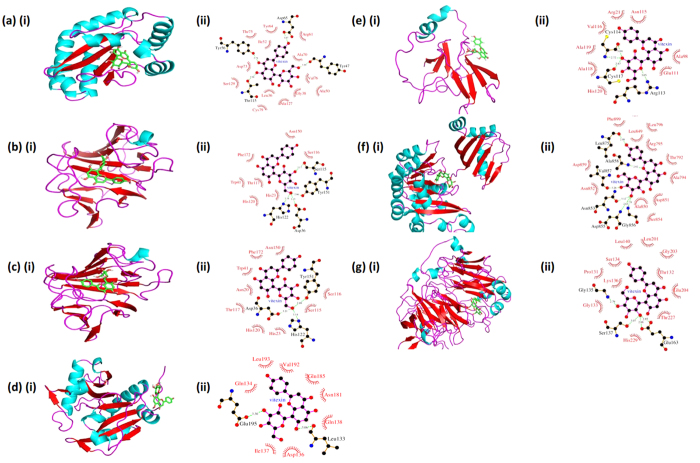
Vitexin docked in different binding pockets of QS and proteins of P. aeruginosa:Cartoon representation of protein-ligand complexes with helices coloured in cyan, beta strand in red and coils in magenta colour. Ligand was coloured green and represented in sticks model. Ligplots of protein-ligand complexes are showing interaction of vitexin with protein residues. (A) (i) Cartoon structure of LuxR with vitexin, (ii) ligplot of LuxR-vitexin complex showing interactions between protein and ligand. (B) (i) Cartoon structure of LasA with vitexin, (ii) ligplot of LasA-vitexin complex showing interactions between protein and ligand. (C) (i) Cartoon structure of LasA with vitexin, (ii) ligplot of LasA-vitexin complex showing interactions between protein and ligand. (D) (i) Cartoon structure of LasI with vitexin, (ii) ligplot of LasI-vitexin complex showing interactions between protein and ligand. (E) (i) Cartoon structure of modelled PilB protein with vitexin, (ii) ligplot of PilB-vitexin complex showing interactions between protein and ligand. (F) (i) Cartoon structure of PilY1 with vitexin, (ii) ligplot of PilY1-vitexin complex showing interactions between protein and ligand. (G) (i) Cartoon structure of PilT with vitexin, (ii) ligplot of PilT-vitexin complex showing interactions between protein and ligand.